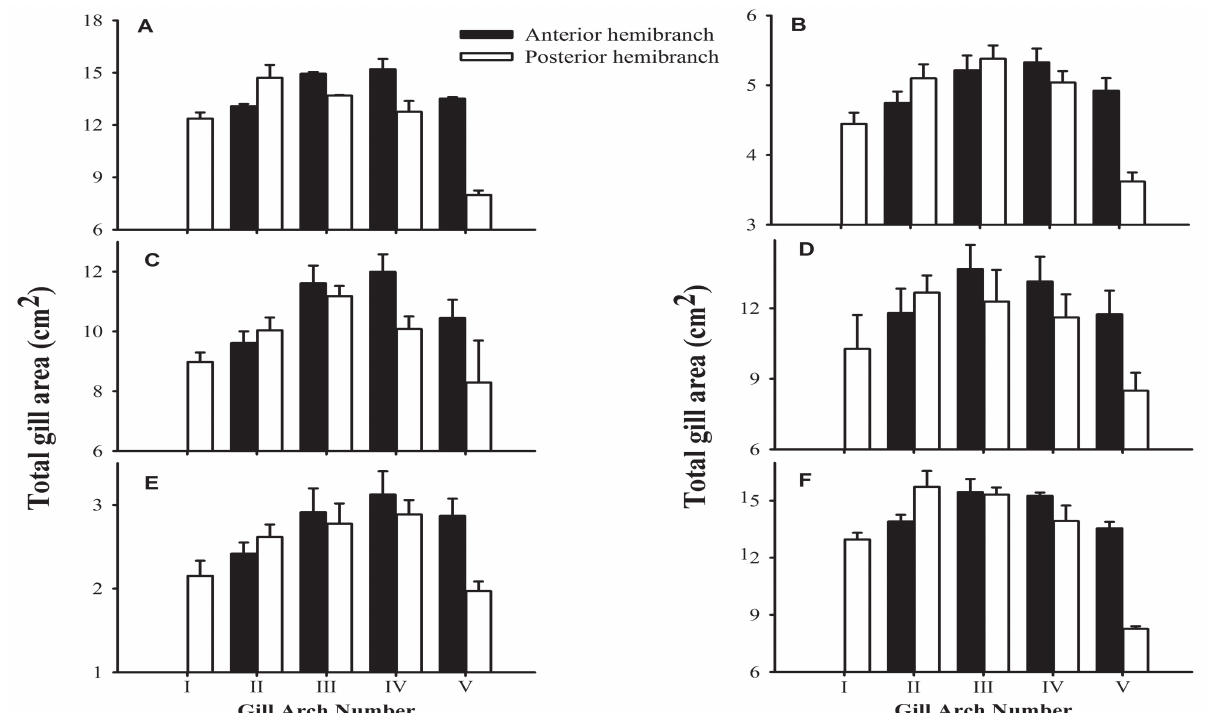
Fig. 2 . Total superficial gill area of the anterior and posterior hemibranchs of the gill arches in different potamotrygonid embryos: (A) Potamotrygon orbignyi ; (B) Potamotrygon sp.; (C) Potamotrygon motoro (from Negro River); (D) Potamotrygon motoro (from Solimões River); (E) Plesiotrygon iwamae ; (F) Paratrygon aiereba.